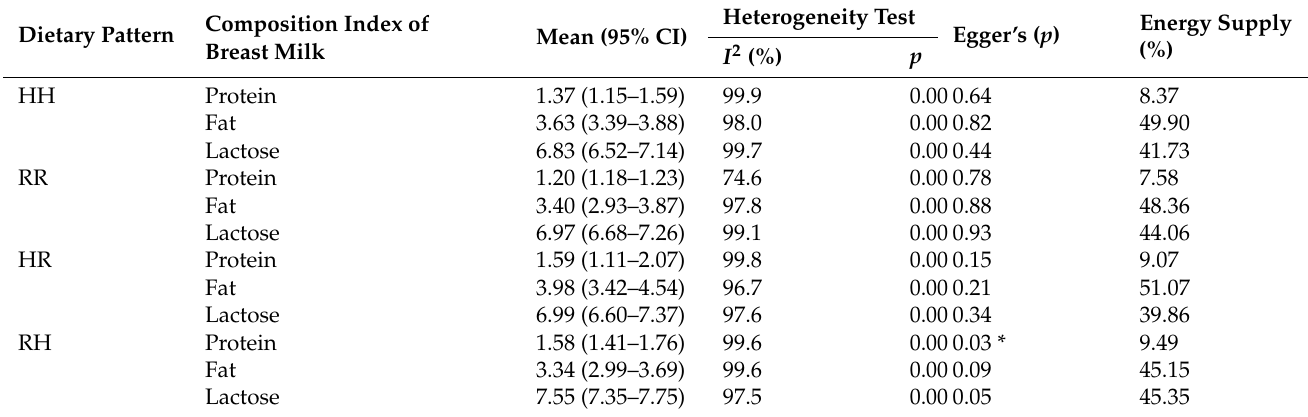
Table 2. Results of analysis of breast milk composition at different dietary